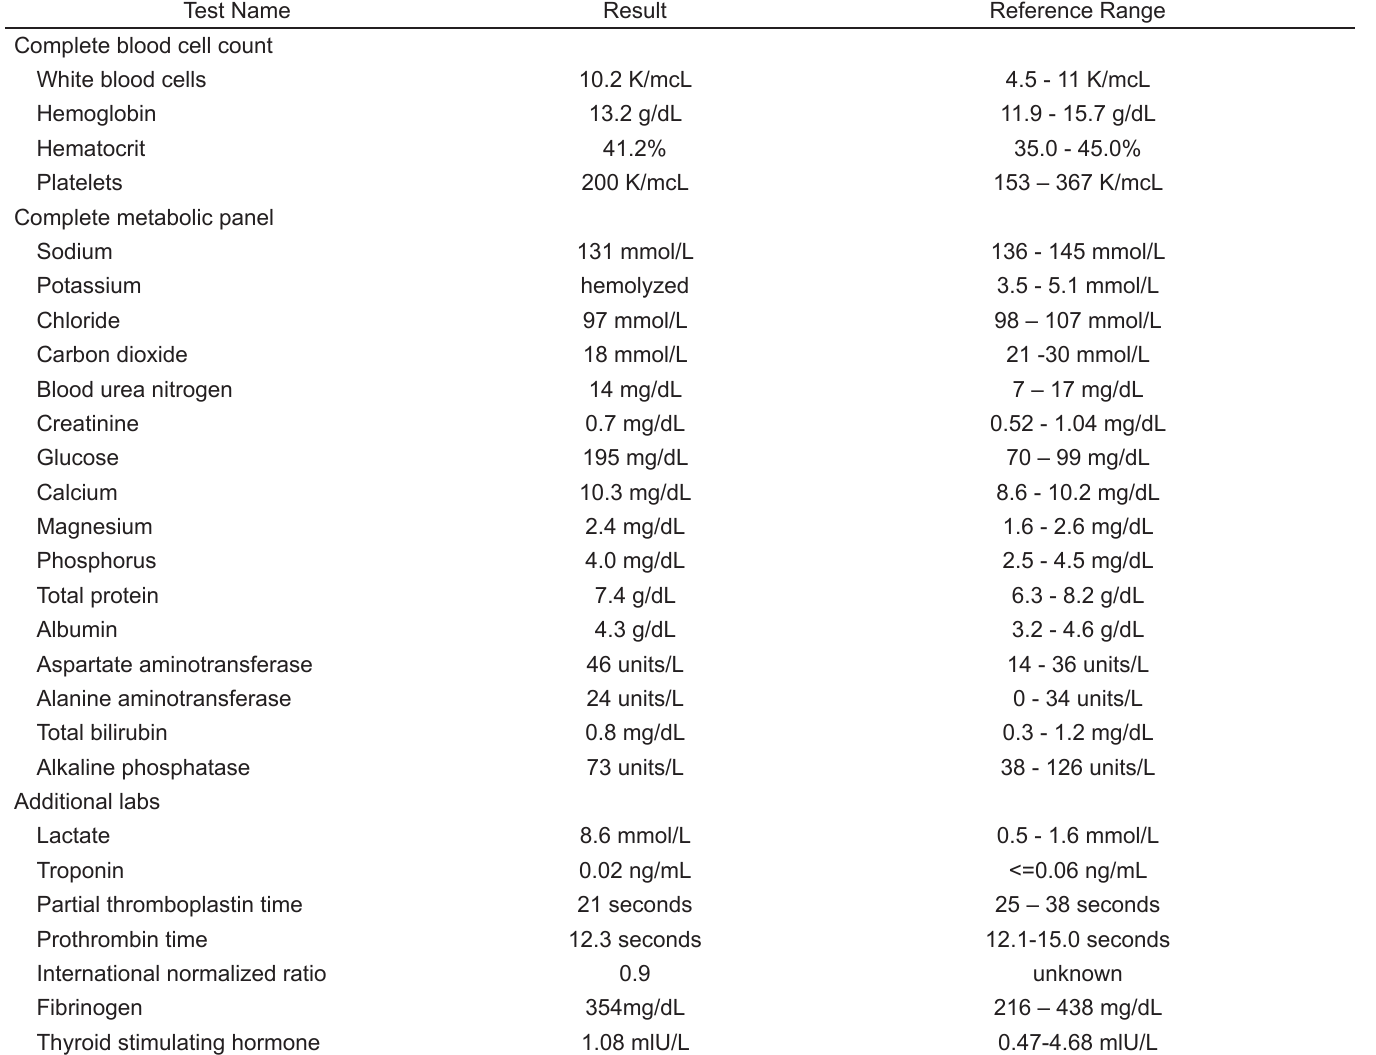
Table 1. Initial laboratory results of 73-year-old female with syncope and subsequent motor vehicle collision.